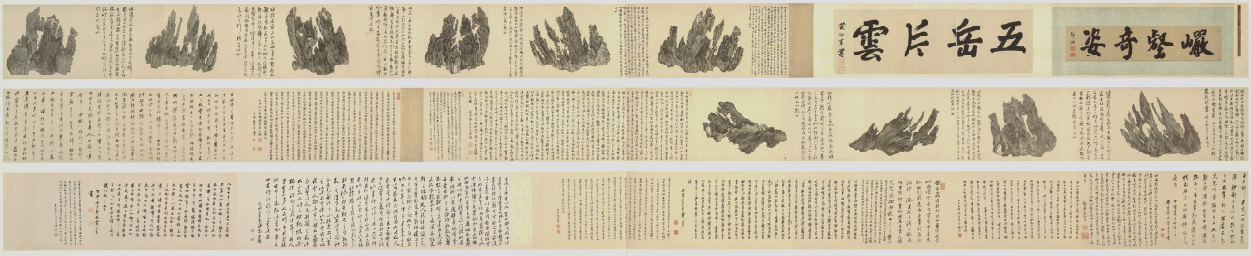
Figure 1. Wu Bin, Ten Views of a Lingbi Rock , 1610. Handscroll, ink on paper, (painting) 55.5 × 1150.0 cm; (colophons) 55.5 × 1387.5 cm. Photo: Courtesy of Poly Art Museum, Beijing (Baoli yishu yan- jiuyuan, 2020).